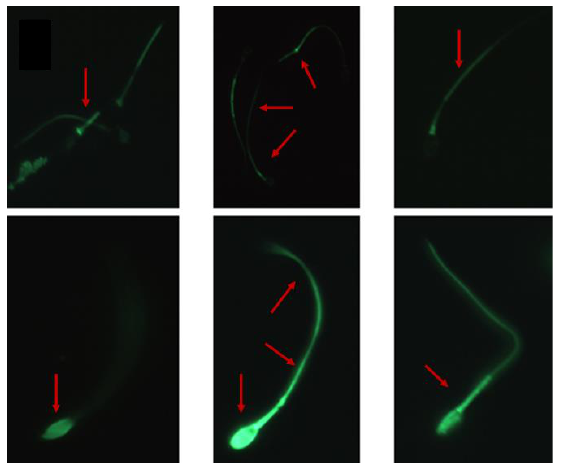
Figure 5. LF/Sod-3 binding to equine spermatozoa. Arrows show variations of LF/SOD-3 binding to different locations on equine sperm (600 ×